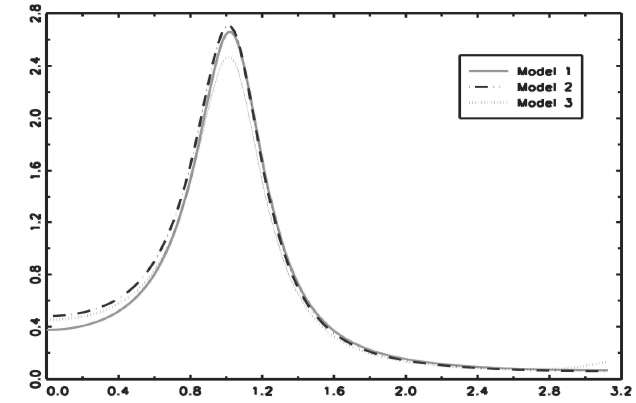
Figure 2 – Operators in the spectral domain of three ARMA